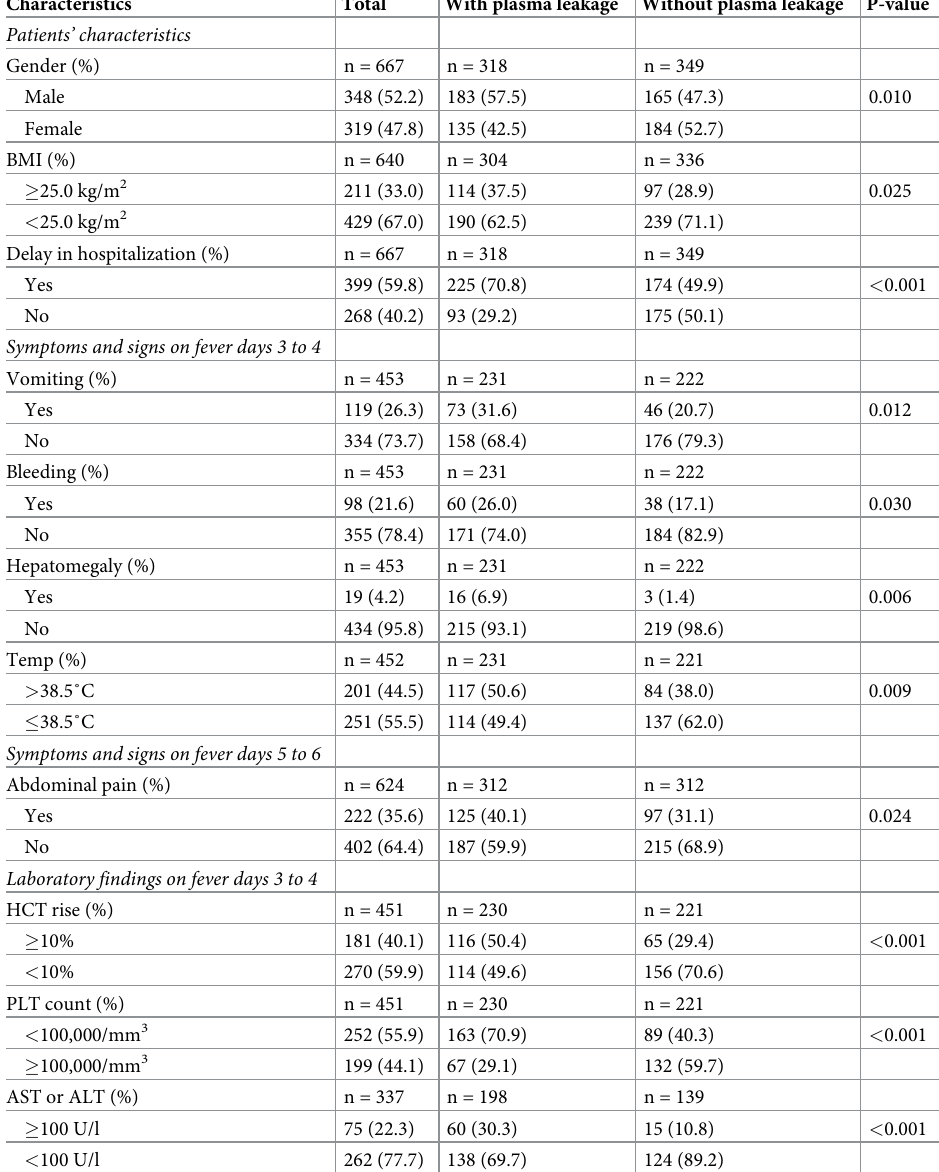
Table 5. Categorical data of patients’ characteristics, clinical, and laboratory findings included in logistic regres- sion analysis. Characteristics